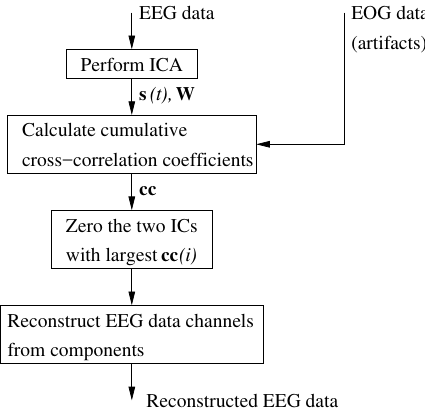
Figure 5. Scheme of the complete removal (CR) approach.